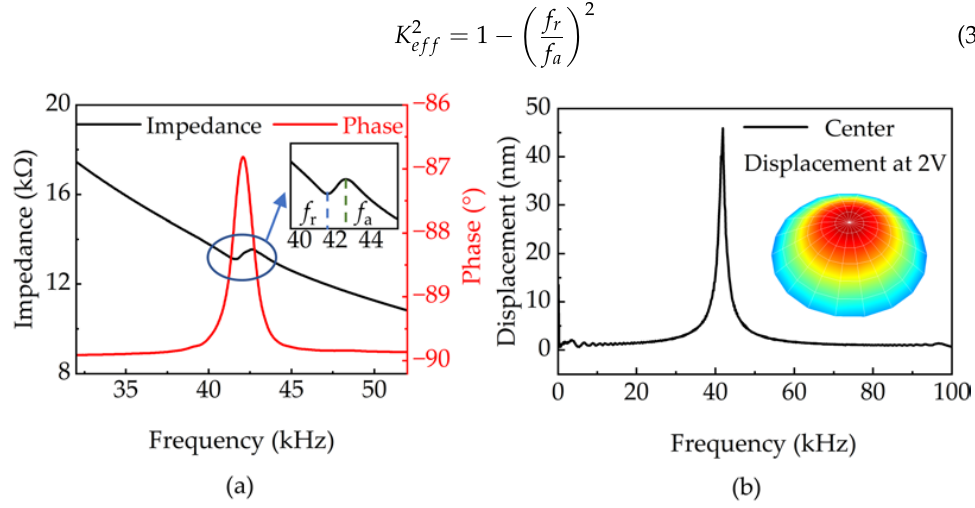
Figure 3. Characterizations of PMUT: ( a ) impedance and phase curves of the PMUT, ( b ) frequency response measurement results using LDV.